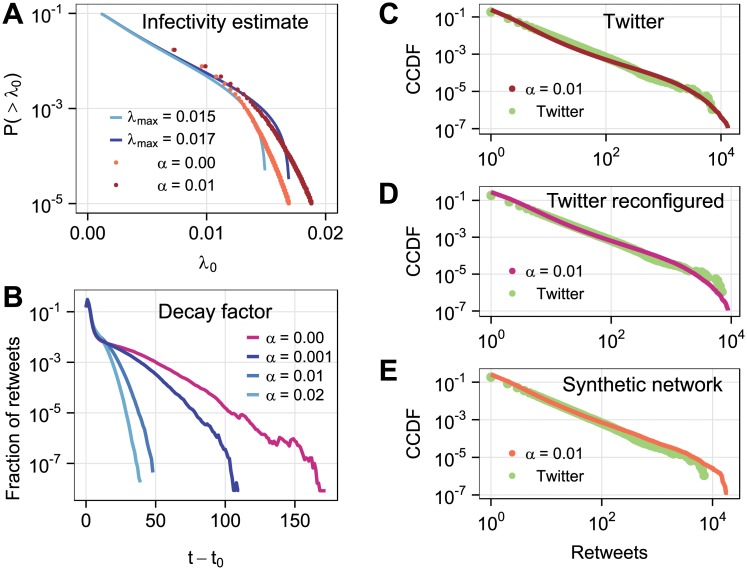
Simulation parameter settings and results.a, Truncated lognormal fit. Light and dark blue lines are fit with theoretical distribution function Eq (6), and the red and orange points are fit with distribution computed from real Twitter data with Eq (4). The parameters used in Eq (6) are as follows: when decay factor α = 0, μ = ln 0.0012, σ = ln 2.4, λmax = 0.015; when α = 0.01, μ = ln 0.0012, σ = ln 2.4, λmax = 0.017. b, Retweets at time t of cascades originated at time t0 with different decay factors. c-e, Complementary cumulative distribution functions (CCDFs)—the fraction of cascades with more than n retweets for numerical simulations, compared with retweets from empirical Twitter data marked by green points. The model parameters are identical except for the network structure: c, The empirical Twitter follower network with N = 5.95 × 105 and 〈k〉 = 47.94; d, Reconfiguration of the empirical Twitter network preserving the degree distribution; e, Scale-free network with N = 5 × 105, 〈k〉 = 48 and exponent γ = 2.8.